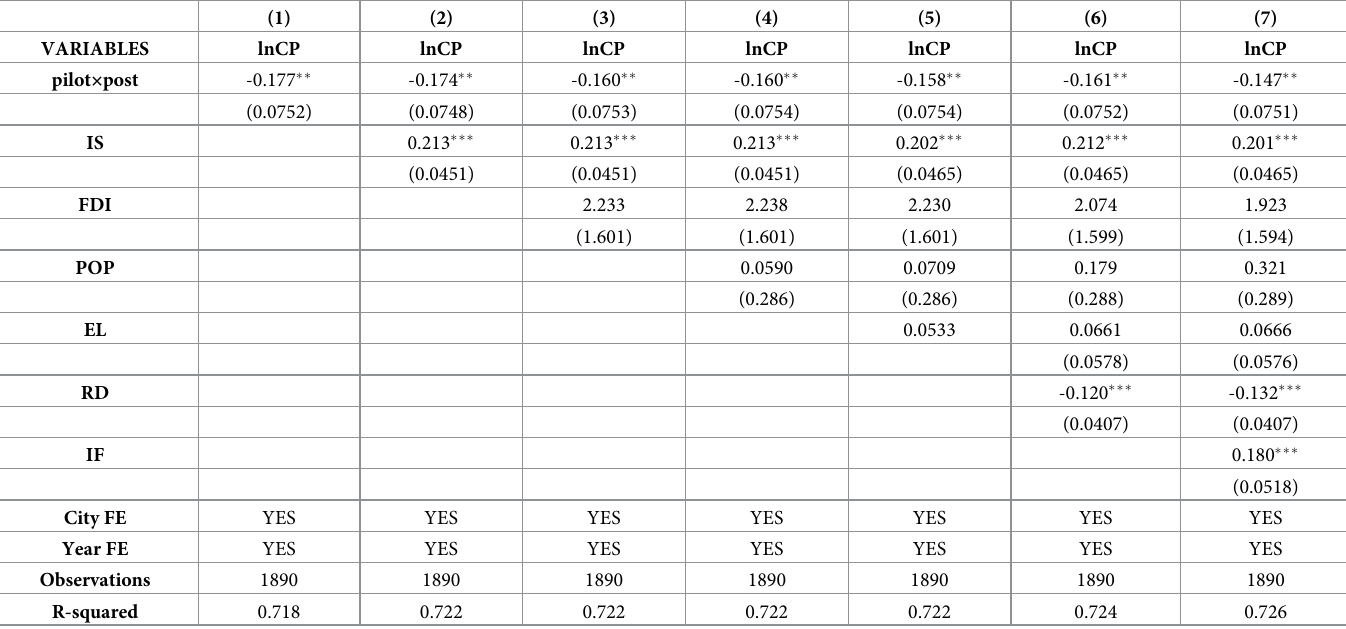
Table 2. Regression results of the LCCP policy on China’s low carbon economic